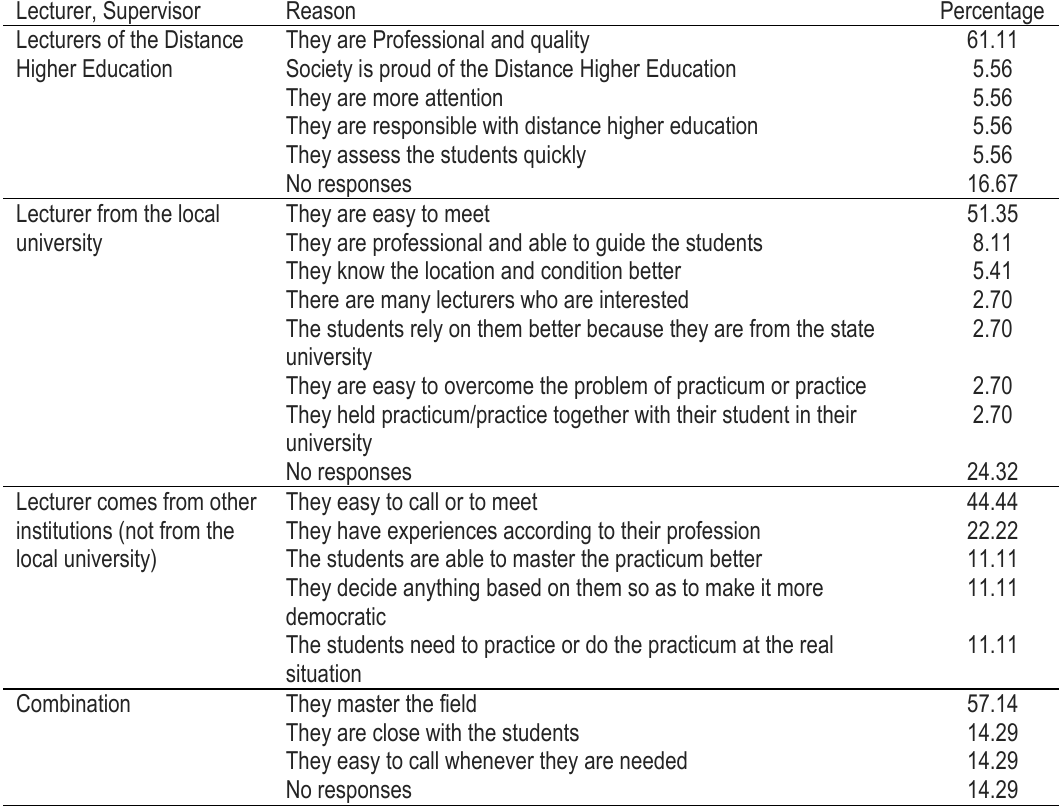
Table 7. Respondents’ Reason for Choosing the Instructor, Counselor, and Supervisor Lecturer,